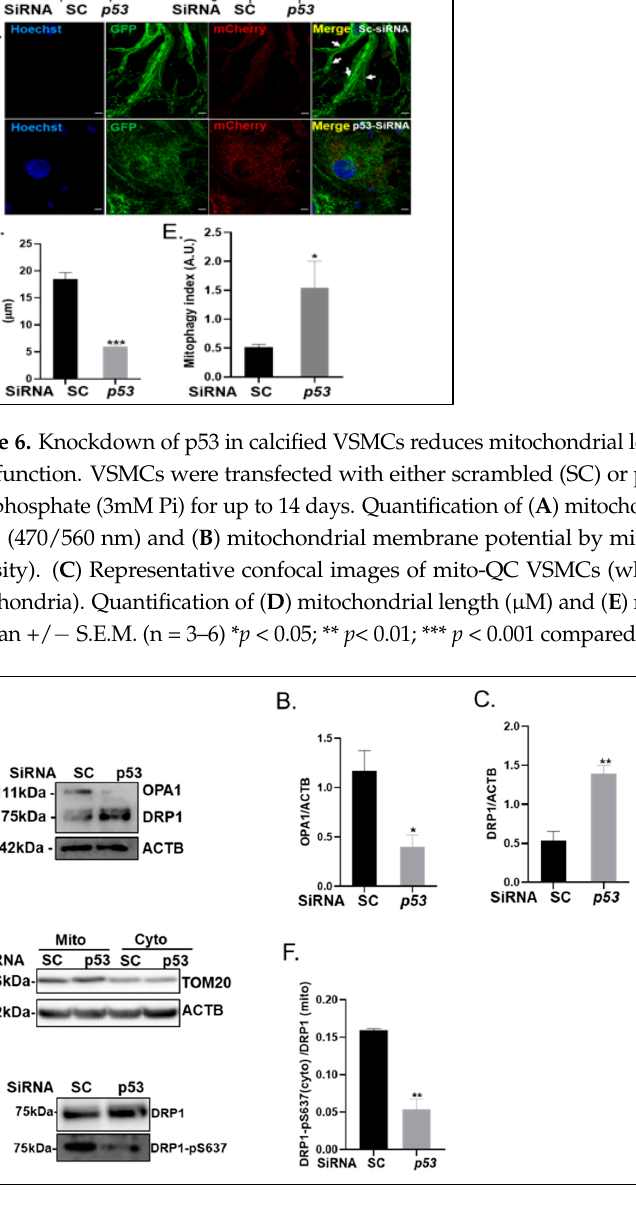
Figure 7. Knockdown of p53 in calcified VSMCs reverses Optic Atrophy Protein 1 (OPA1) and Dynamin-related protein 1 (DRP1) protein expression. VSMCs were transfected with either scrambled (SC) or p53 siRNA and cultured with high phosphate (3mM Pi) for up to 14 days. ( A ) Representative immunoblotting of whole cell lysates and associated quantification of ( B ) OPA1 and ( C ) DRP1 expression compared with ACTB ( β -actin). ( D ) Representative immunoblotting of the mitochondrial and cytoplasmic fractions with TOM20 and ACTB from scrambled (SC) and p53 SiRNA transfected VSMCs. ( E ) Representative immunoblotting of mitochondrial expression of DRP1 and cytoplasmic expression of DRP1 -pS637 and associated quantification of ( F ) ratio of cytoplasmic DRP1- pS637 / mitochondrial DRP1. Data shown as mean +/ − S.E.M. (n = 3–6) * p < 0.05; ** p < 0.01 compared to control.